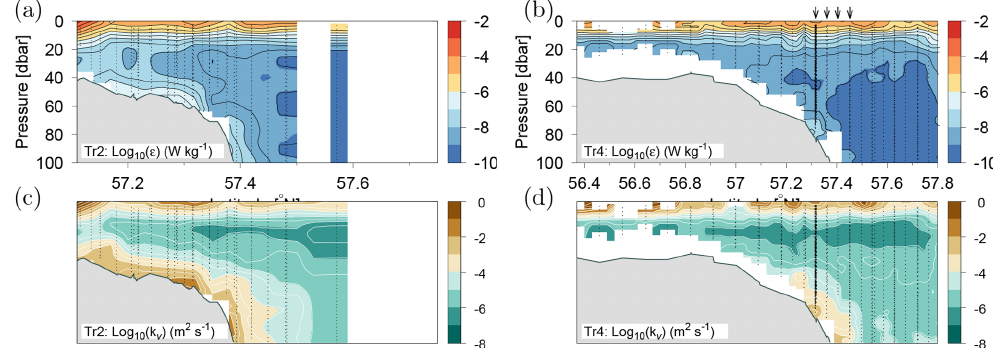
Figure 5. Turbulence measurements along Tr2 (a, c) and Tr4 (b, d) . (a, b) Logarithm (Log 10 ) of dissipation of turbulent kinetic energy (Wkg − 1 ) and (c, d) calculated vertical turbulent diffusion coefficient (m 2 s − 1